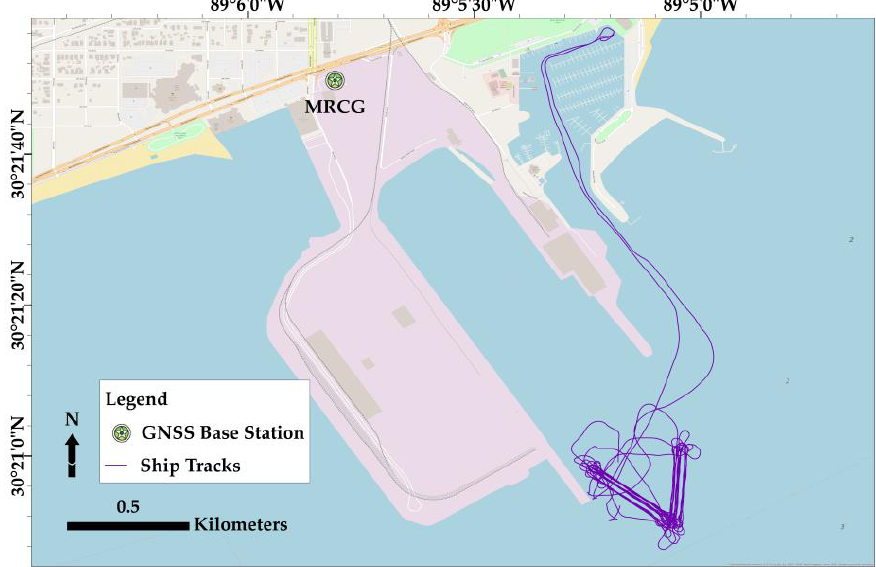
Figure 2. Survey track lines at the experiment location. The water depth is up to 11 m, and the swath width for Norbit iWBMS 12004 acquisition is 130